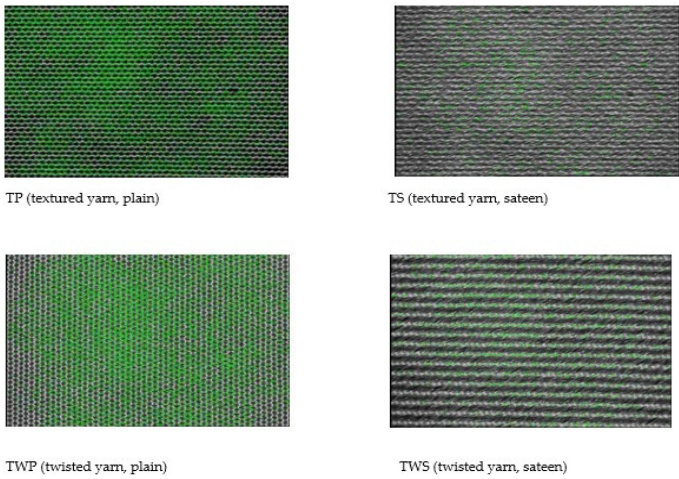
Figure 4. The distribution of porous surfaces on the fabric surface.